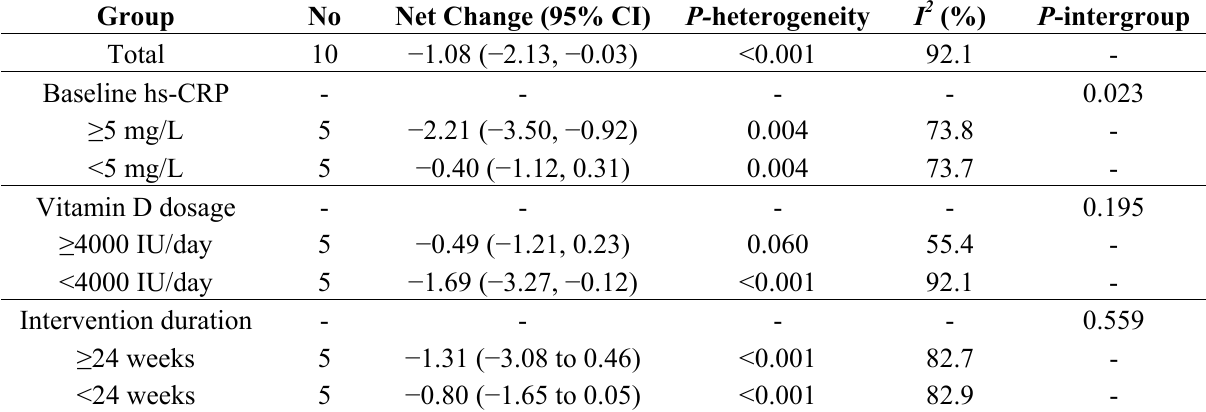
Table 2. Results of subgroup analyses according to trial or participant